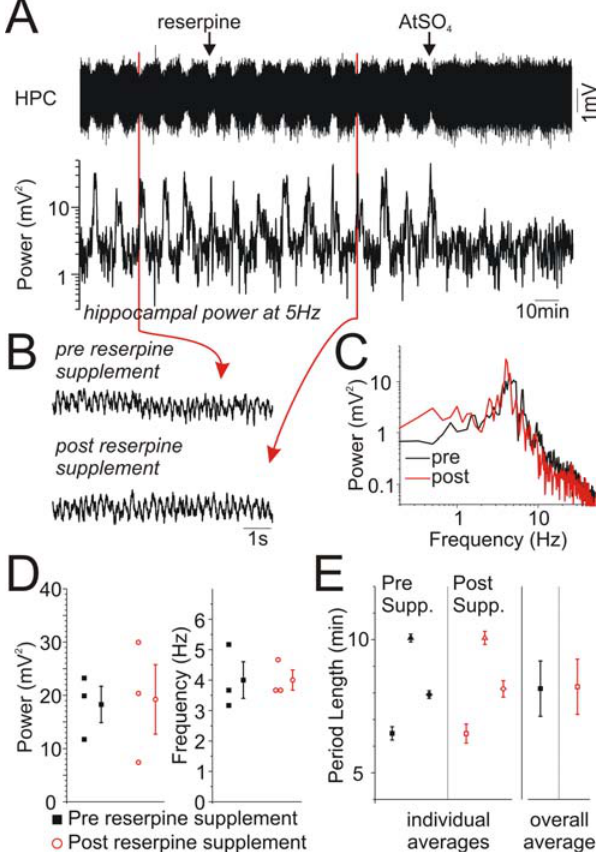
Figure 9. Monoaminergic depletion affected neither the activated state nor the alternations between states under urethane anaesthesia. A) Continuous hippocampal EEG traces and spectrographic power at theta frequencies under urethane